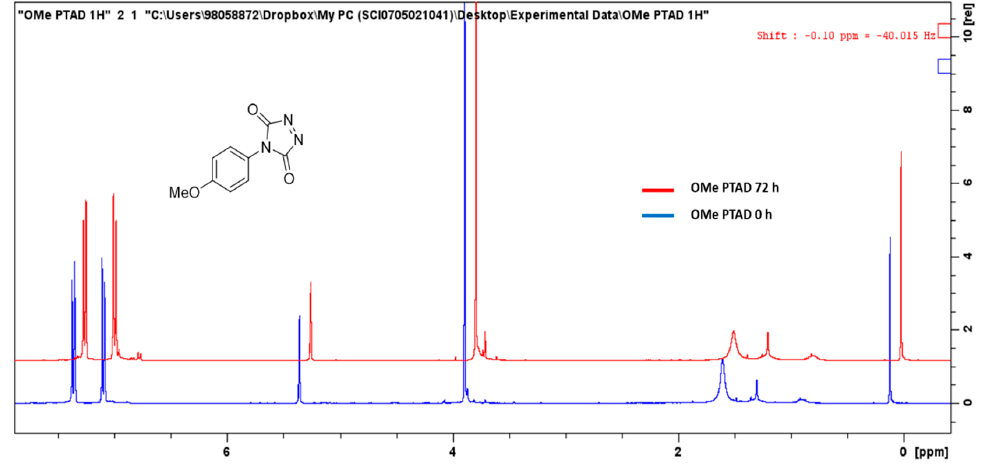
Figure 1. 1 H-NMR of 4-[4-(methoxy)phenyl]-1,2,4-triazole-3,5-dione ( 5f ) stock solution immediately after preparation (red) and after 72 h in CDCl 3 (blue).